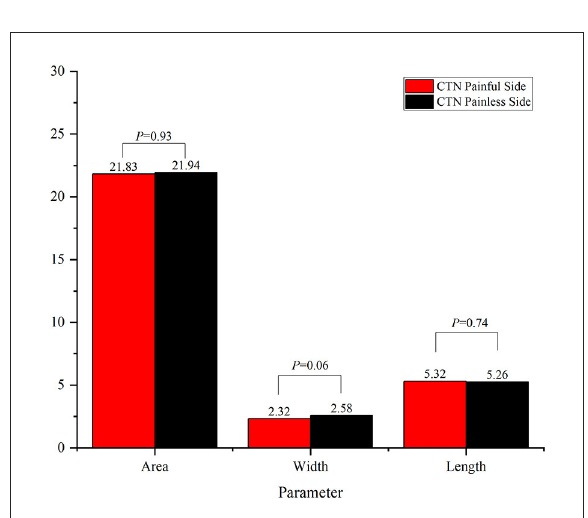
FIGURE4 Morphometric differences between the painful side and the painless side in the CTN group.